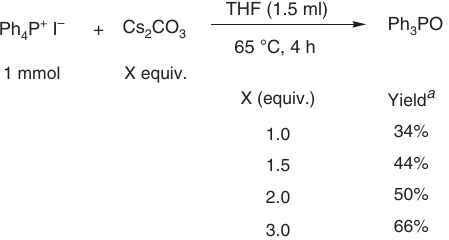
Figure 4 | Evidence to support the Cs 2 CO 3 promoted arylation without water. The more Cs 2 CO 3 was used for the reaction of Ph 4 P þ I (cid:2) with Cs 2 CO 3 for the same period of time, the more Ph 3 PO was produced, a yields were determined by 31 P